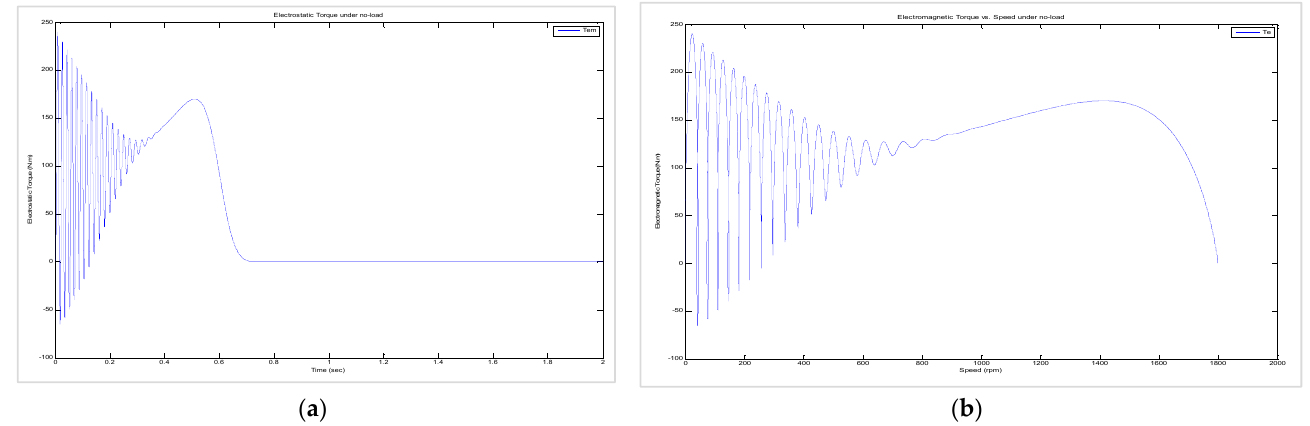
Figure 17. ( a ) Electromagnetic torque under no-load; ( b ) electromagnetic torque vs speed under no-load.